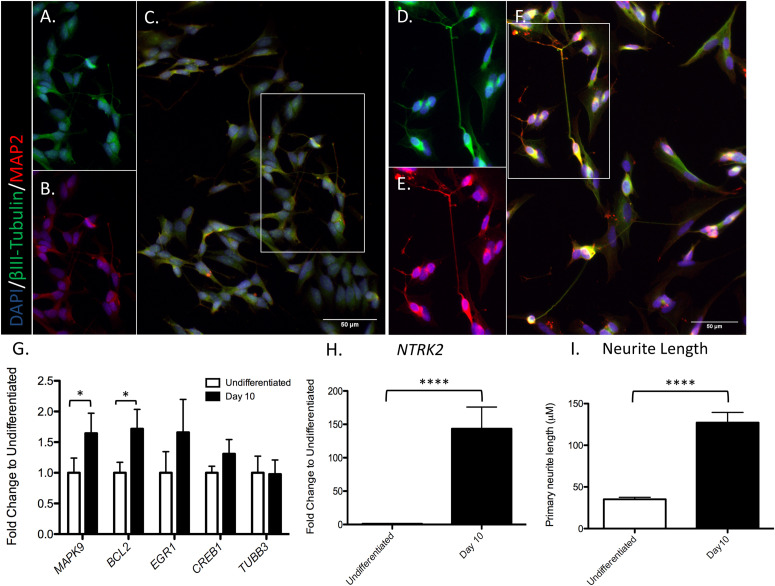
SH-SY5Y cell differentiation. Cells were marked for nucleus DAPI (blue), MAP2 (red), and βIII-Tubulin (green) in an undifferentiated state (A–C) or after 10 days of differentiation (D–F). A selection of neurons in the image were chosen to split by channel (βIII-Tubulin or MAP2), identified by the white box in C and F. (A) Selection of undifferentiated cells, βIII-Tubulin. (B) Selection of undifferentiated cells, MAP2. (C) Full image undifferentiated cells, merge of βIII-Tubulin and MAP2. (D) Selection of 10 days differentiated cells, βIII-Tubulin. (E) Selection of 10 days differentiated cells, MAP2. (F) Full image of 10 days differentiated cells; merge of βIII-Tubulin and MAP2. (G) RT-qPCR analysis was used to assess the expression of the indicated genes in differentiated and undifferentiated cells. (H) Significant increase in NTRK2 expression at day 10 of differentiation. (I) Significant increase in primary neurite outgrowth at day 10 of differentiation. Values represent mean ± SEM (∗P < 0.05, ****P < 0.001, and Student’s t-test).